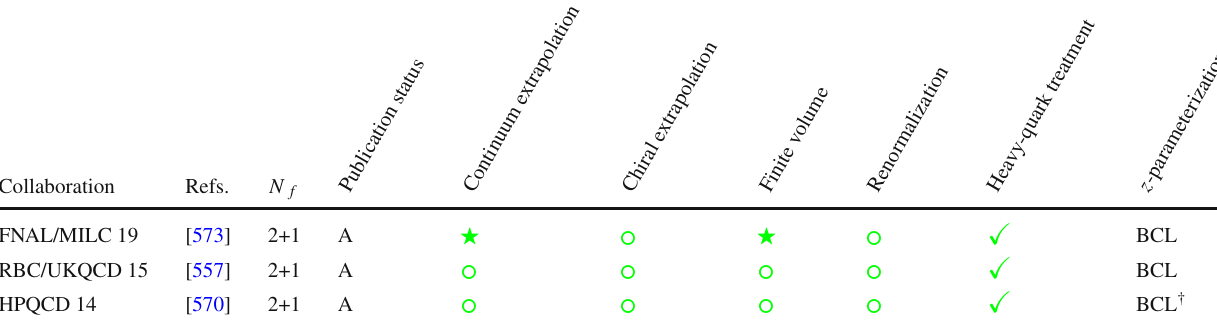
Table 47 Summary of lattice calculations of the B s → K (cid:6)ν semileptonic form factors